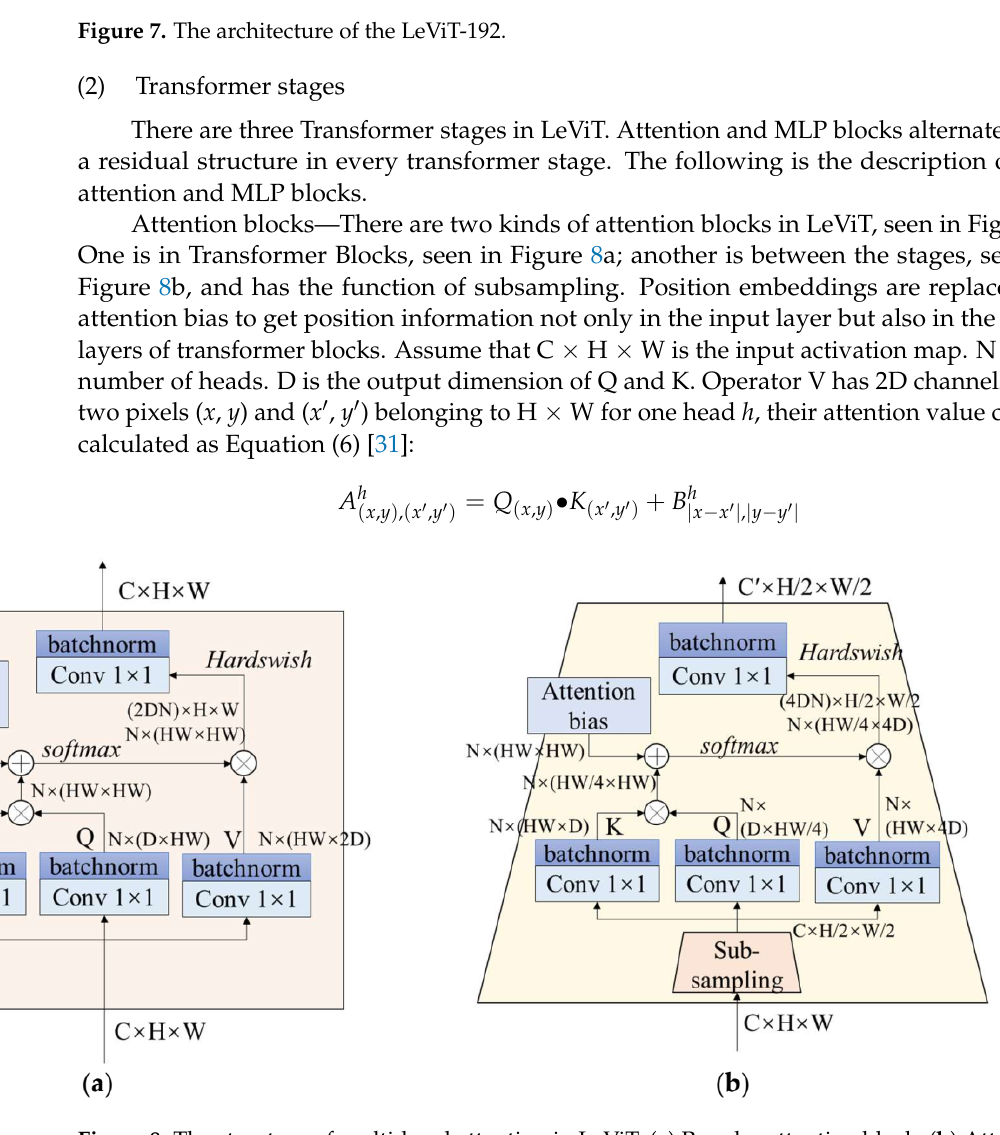
Figure 8. The structure of multi-head attention in LeViT: ( a ) Regular attention block; ( b ) Attention block with subsampling function (shrink attention blocks). C is the channel of feature maps, and H and W represent the height and width, respectively, of the feature map. N is the number of self-attention heads. D is the output dimension of key K and query Q. Operator V has 2D channels. MLP blocks—The structure of MLP in traditional ViT is linear transformation. In